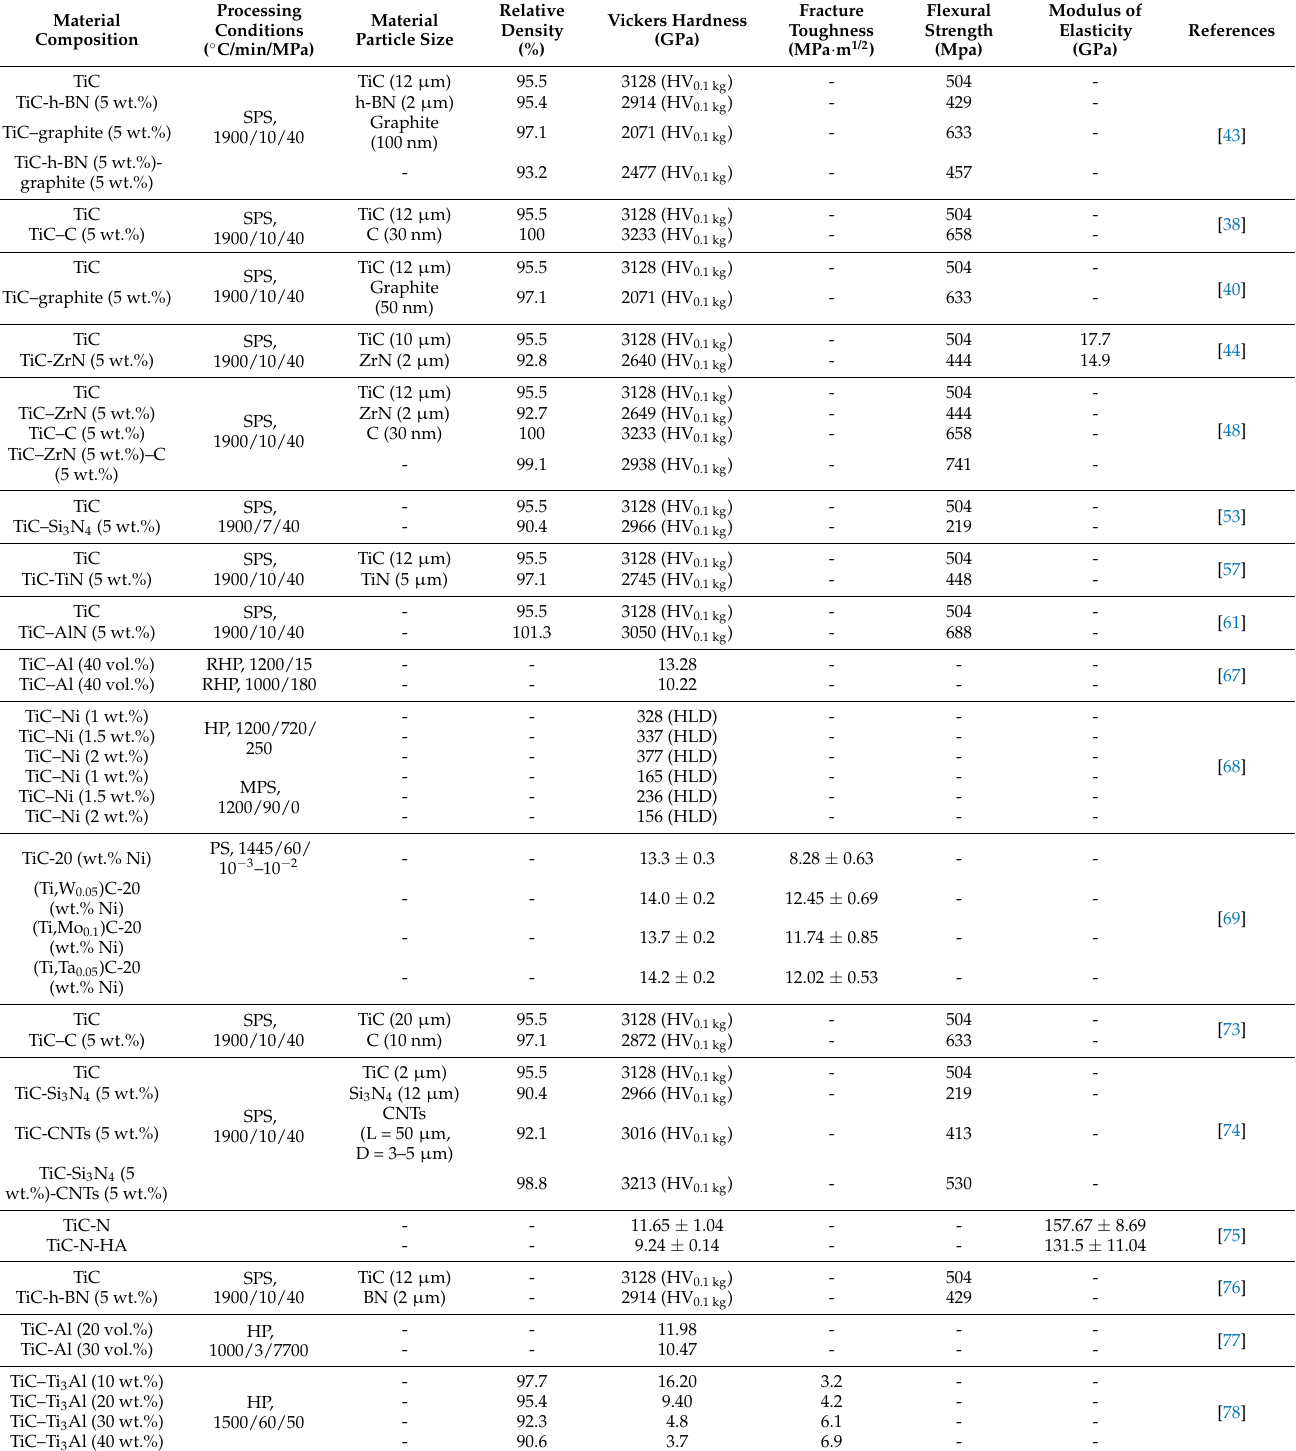
Table 2. Effects of the preparation conditions and sintering additive on the mechanical properties of TiC